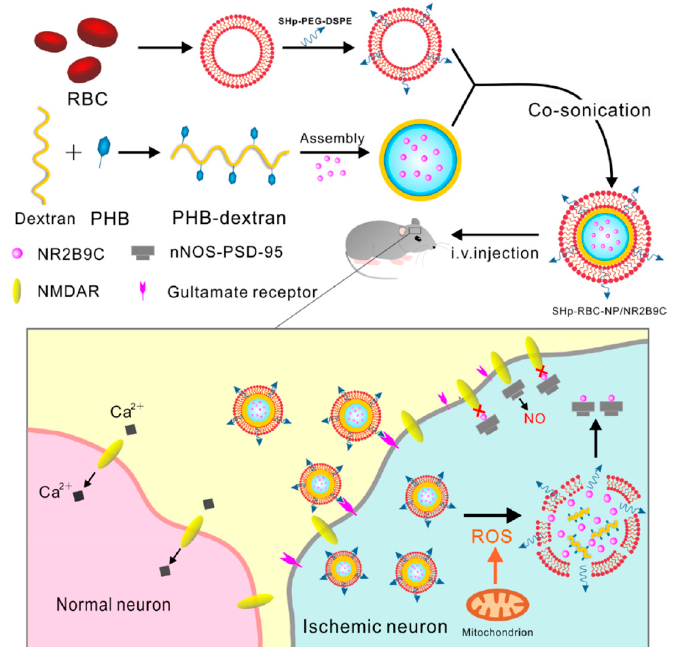
Figure 5. Schematic representation of SHp-RBC-NP / NR2B9C. Reproduced with permission from [67]. ACS (2018).